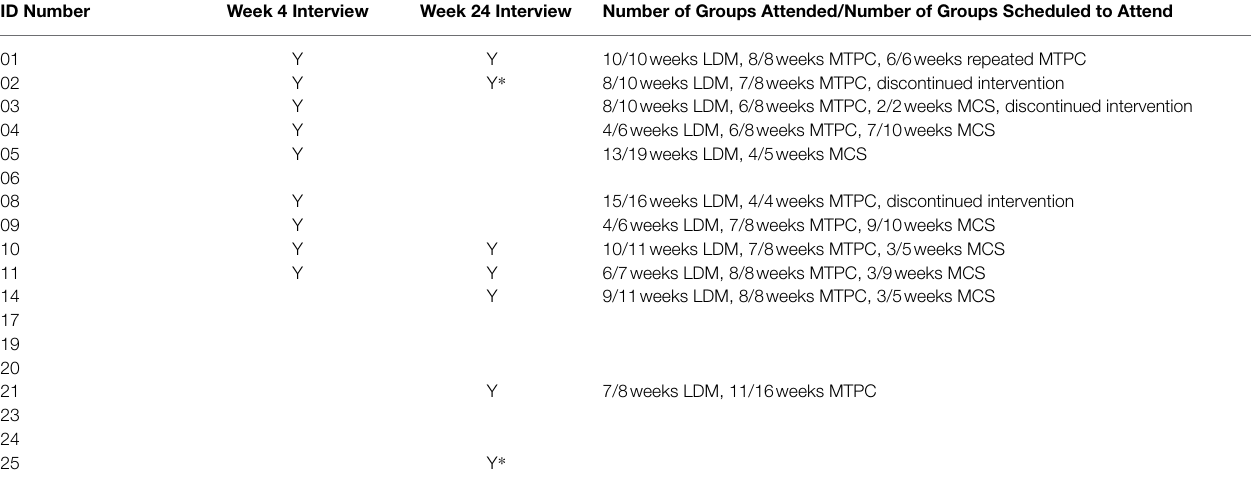
TABLE 1 | Participant interview participation and exposure to M-ROCC. ID